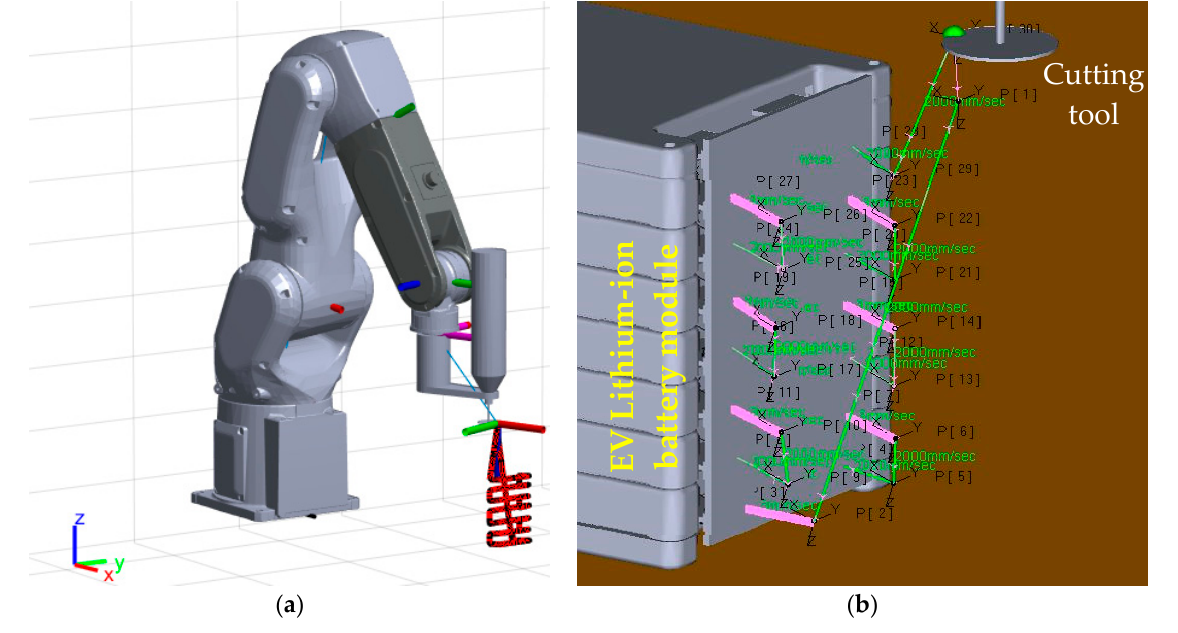
Figure 6. ( a ) Robot motion simulation to evaluate the motion of various joint states, ( b ) cutting path for a retired EV battery module to make it ready for recycling.